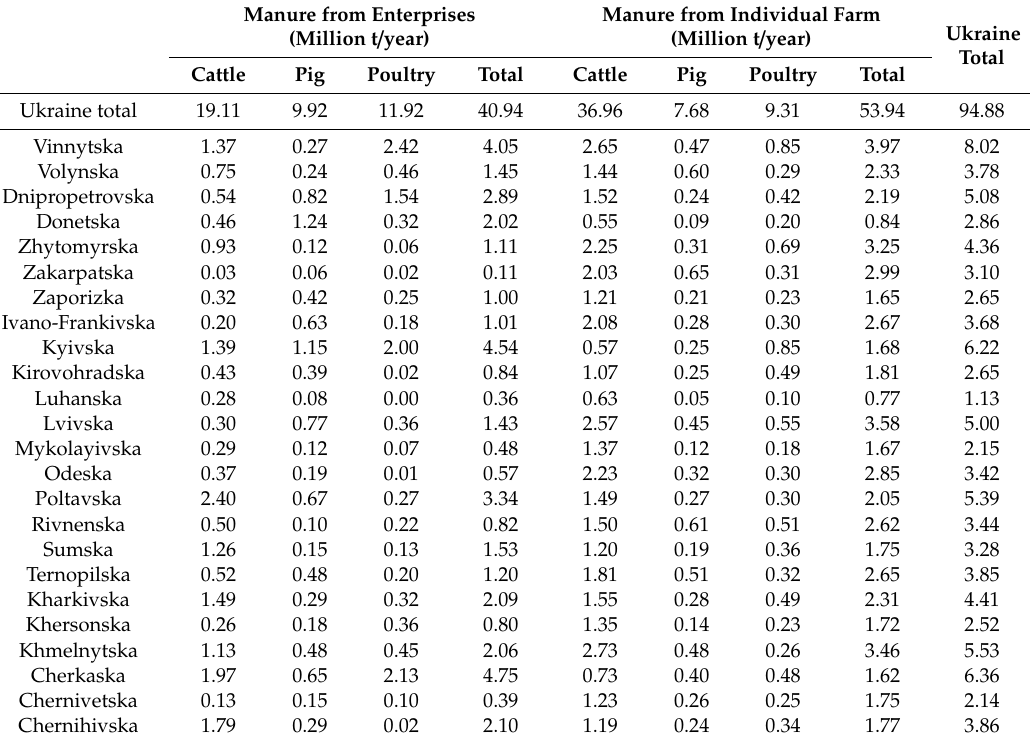
Table 3. Manure production by Ukrainian regions (million tonnes / year). Manure from Enterprises Manure from Individual Farm (Million t / year) (Million t / year) Ukraine